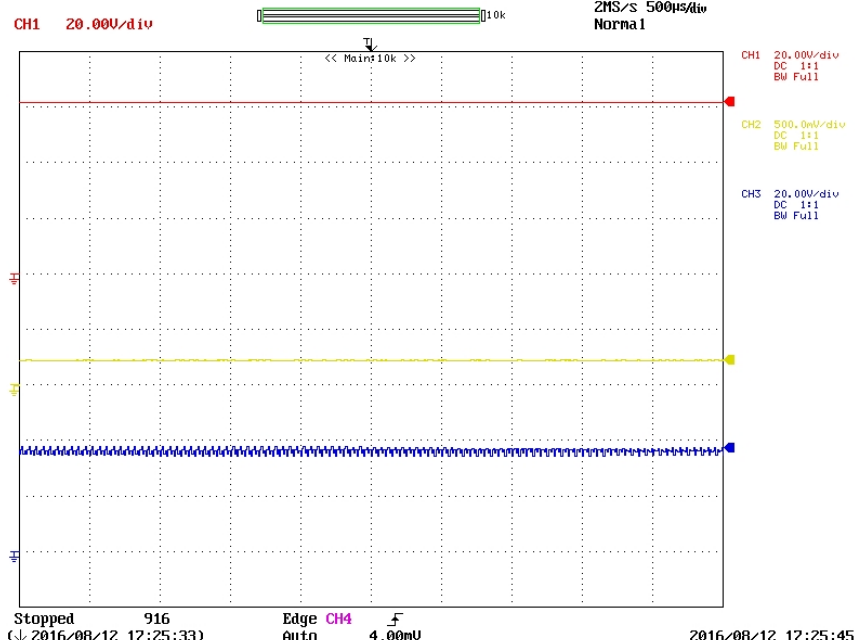
Figure 20. Results (for 13:00) obtained by hardware implementation: CH1 : voltage across the load resistance (62.5 V); CH2 : current across the load (1.6 A); and CH3 : solar PV array’s terminal voltage ( V PV = 34.9 V).